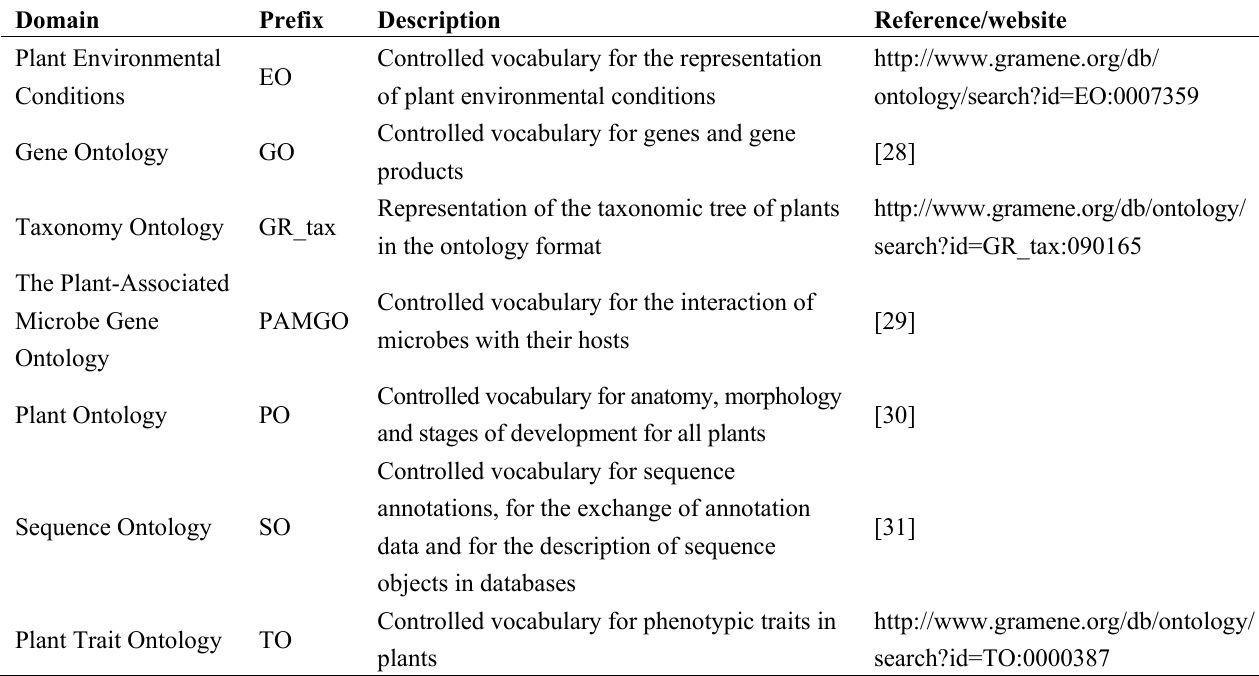
Table 3. List of ontologies containing information related to crop stress